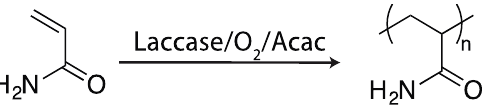
Figure 7. Acrylamide is polymerized into poly(acrylamide) in the presence of laccase, oxygen, and acetylacetone (Acac) [58].